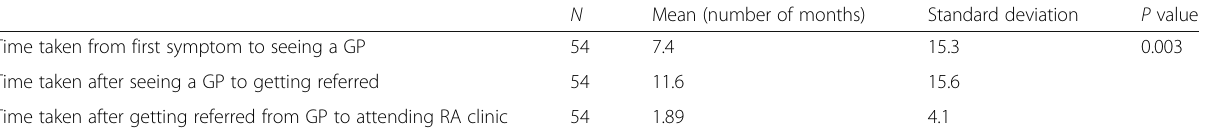
Table 2 Time taken (in months) for the subjects from 1st symptom to seeing a GP, seeing the GP to being referred to RA clinic, and from date of referral to attending the RA